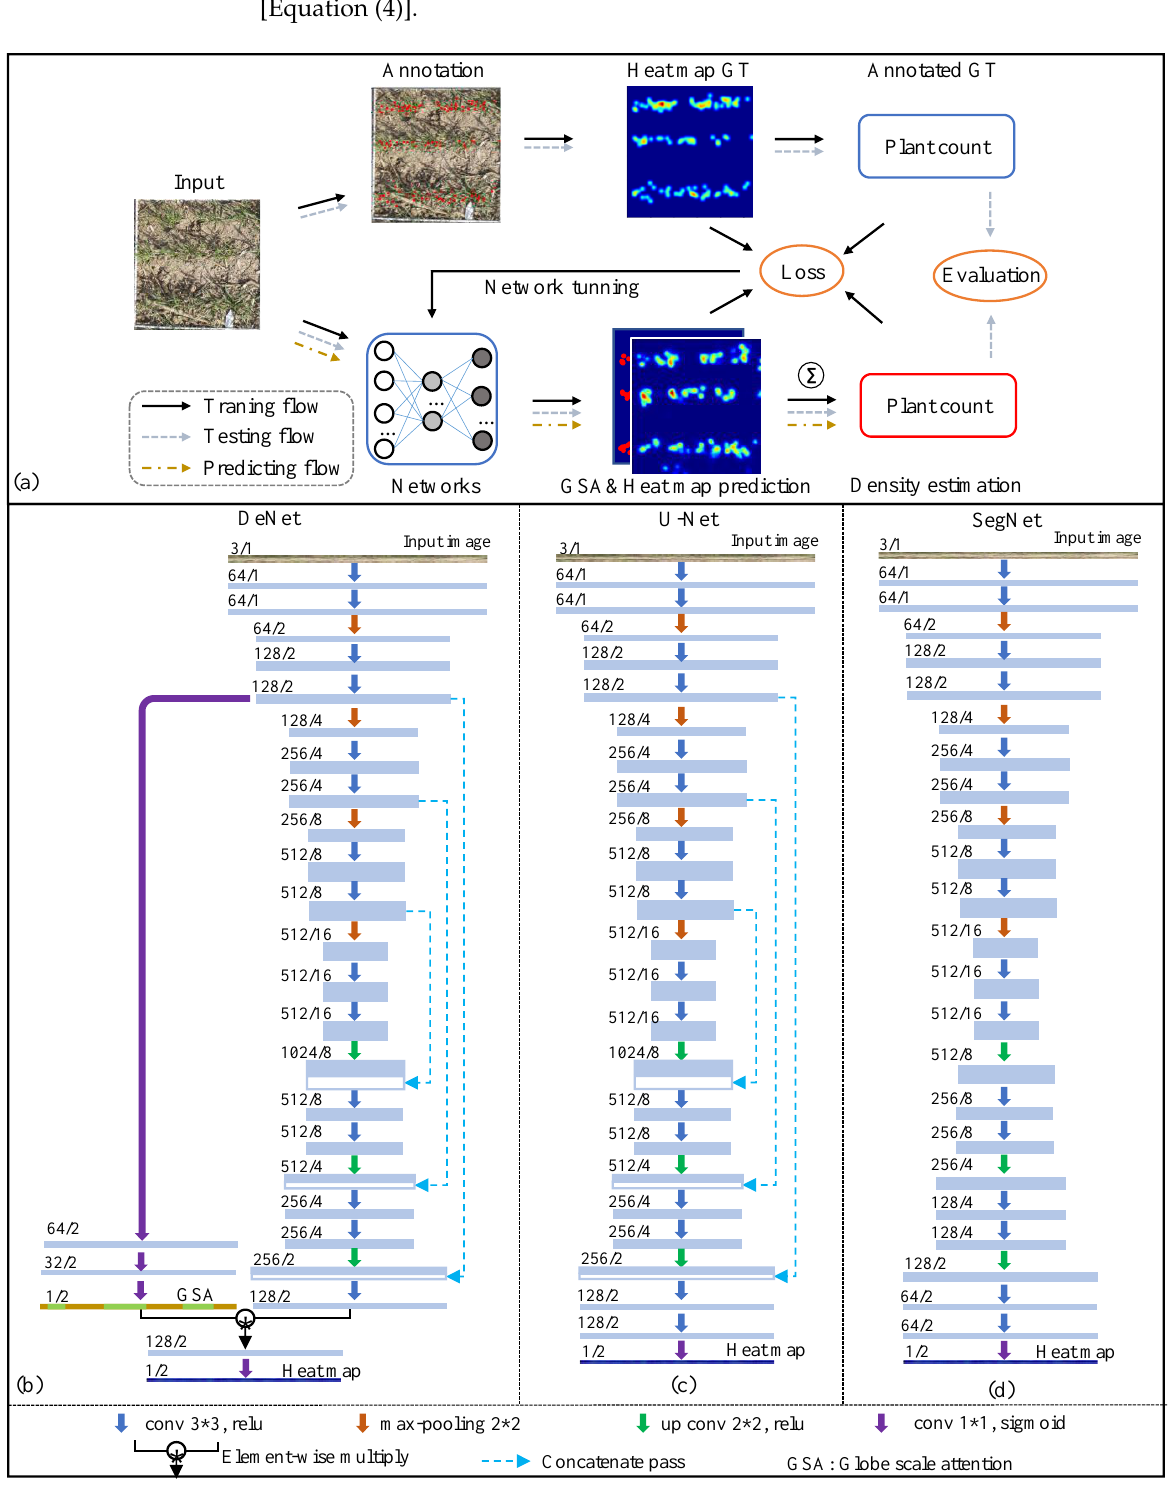
Figure 3. ( a ) An overview of the workflow for plant density estimation and network architecture of three models used in this study. ( b ) DeNet, ( c ) U-Net, and ( d ) SegNet. The m and n in the ‘ m / n ’ label at the upper left of each layer represent layer channel number and down-sampling stride, respectively. GT represents ground-truth.